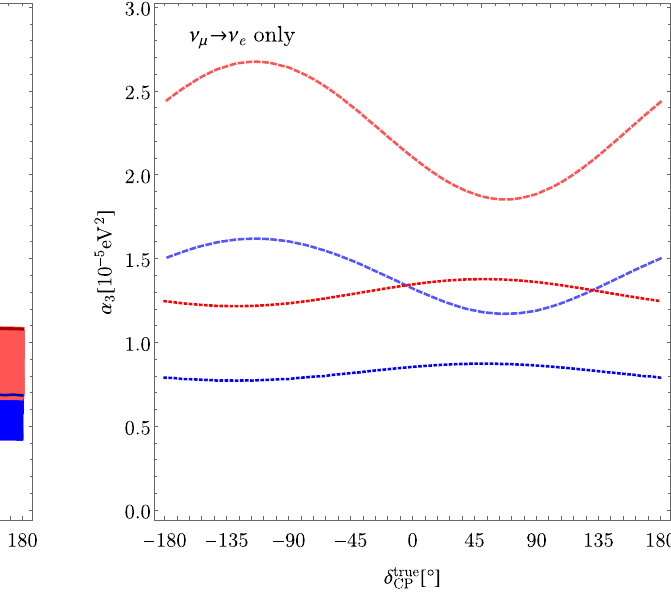
Fig. 5 As in Fig. 4, but as a function of δ true